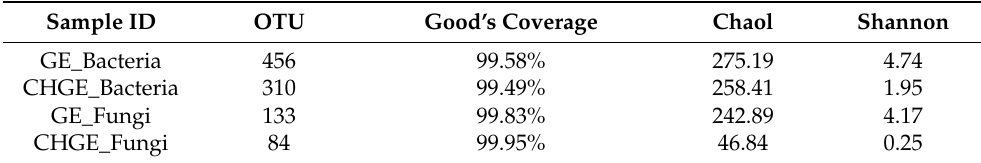
Table 1. OTUs, Good’s coverage, and Chaol’s and Shannon’s index for high-throughput sequencing of 16S rRNA and 18S rRNA sequencing of the bacteria and fungi in GE and